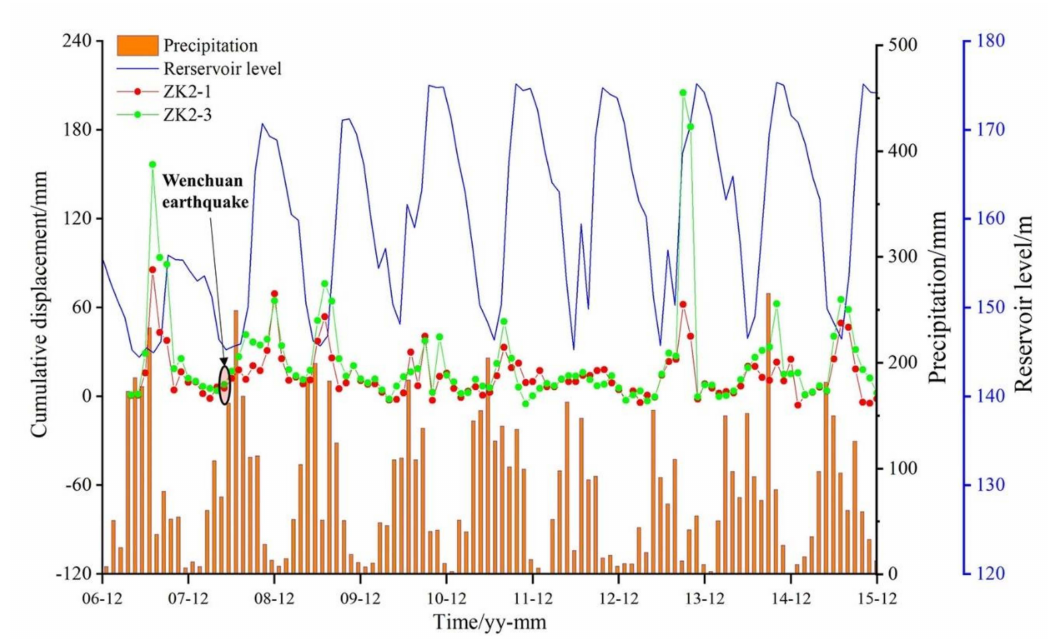
Figure 11. Rainfall, reservoir water level, and displacement increment of ZK2-1 and